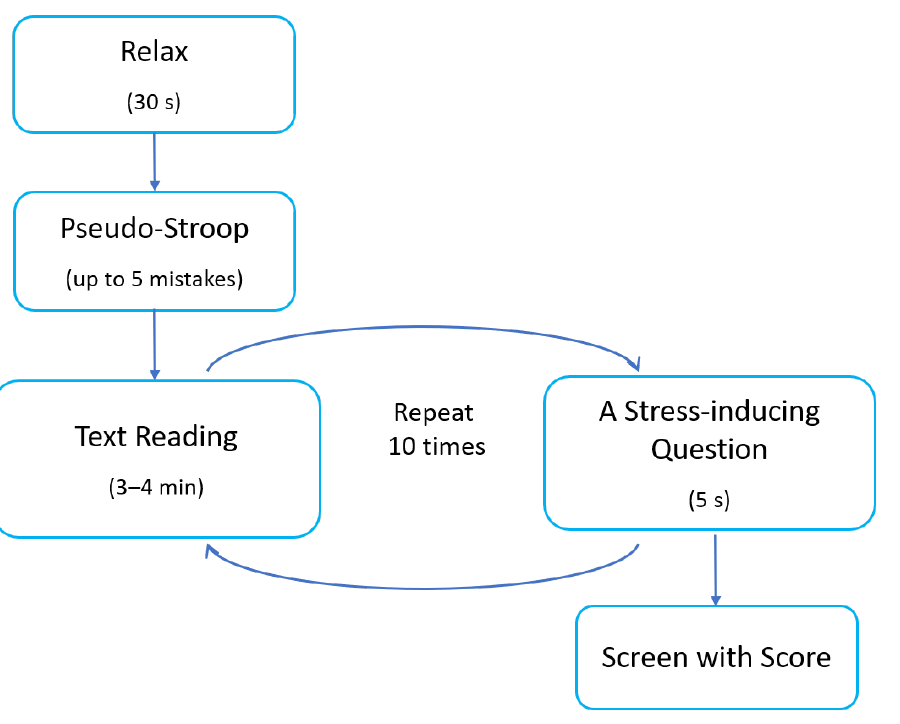
Figure 2. The order of events in Task